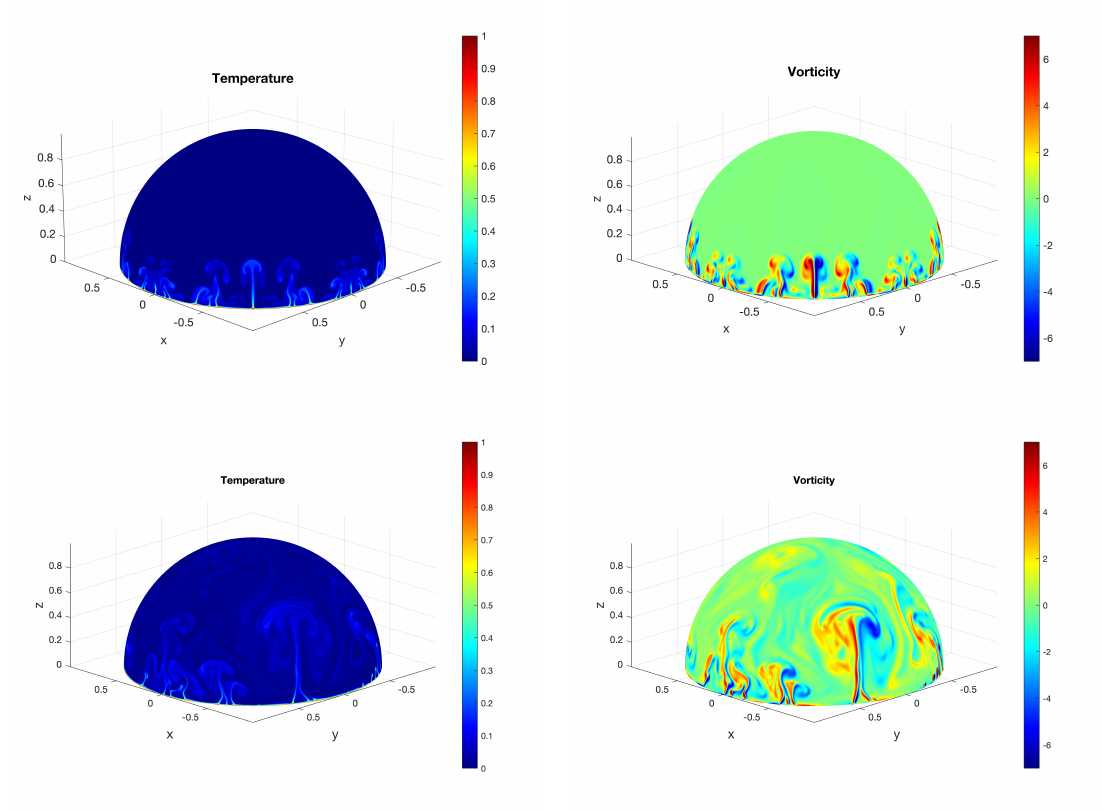
Figure 3. Top: Beginning of the simulations; mushroom shape structures are created at the equator. Bottom: Stationary state; plumes move up on the bubble and the structures start to interact with each other. Left: Temperature fields. Right: Vorticity